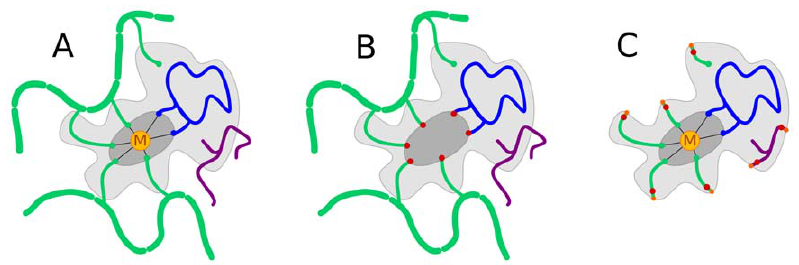
Figure 1. Schematic representation of the DMD/QM domains. A) The dark shaded area defines the QM-only domain, the light shaded area is the QM-DMD domain, and the rest of the system constituted the DMD-only domain. Protein backbone is shown as thick green lines. Amino acids holding the metal ( M ) are depicted as thin green lines. The catechol substrate coordinated to M is shown in blue. SAM is shown in purple; notice that only part of it is included in the QM-DMD domain. B) Representation of the system as seen during the DMD phases of the simulation: red dots depict atoms that are frozen. C) Schematic model of the system during QM calculations: atoms that are bordering with the DMD-only domain are frozen and their valences are saturated with hydrogen atoms (orange